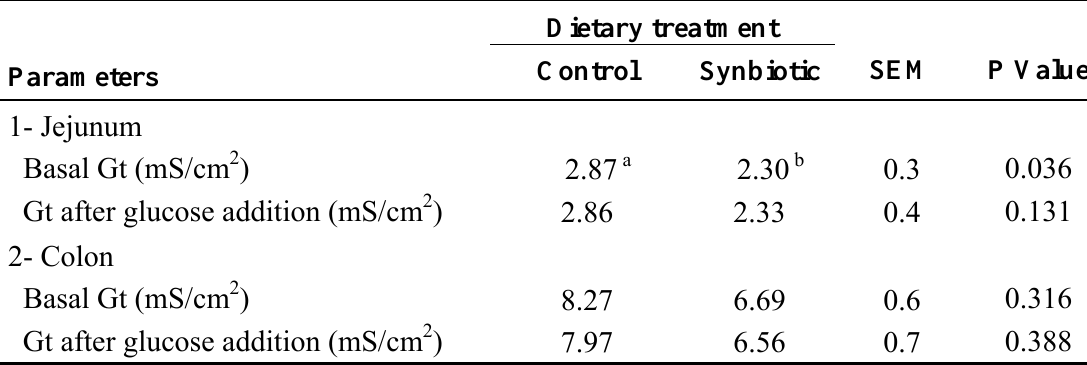
Table 5. Tissue conductance (Gt , mS/cm 2 ) across the isolated jejunal and colonic mucosa of broilers after glucose